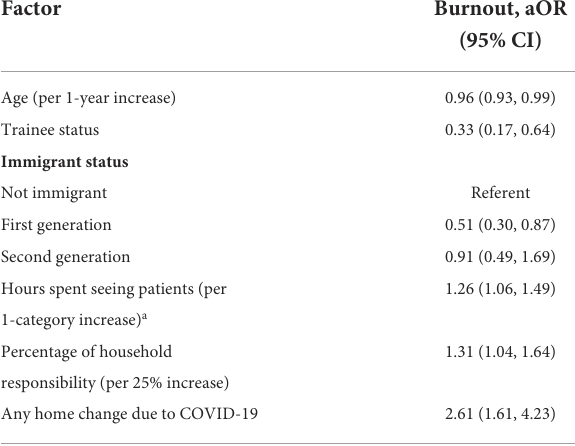
TABLE 5 Factors most associated with emotional burnout *